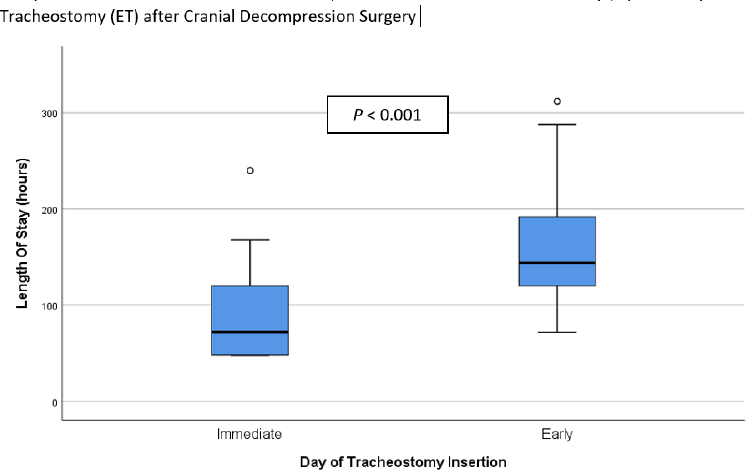
Figure 2. Comparison of Neuro HDU/ICU Length of Stay (LOS) between Immediate Tracheostomy (IT) and Early Tracheostomy (ET) after decompressive craniectomy surgery.